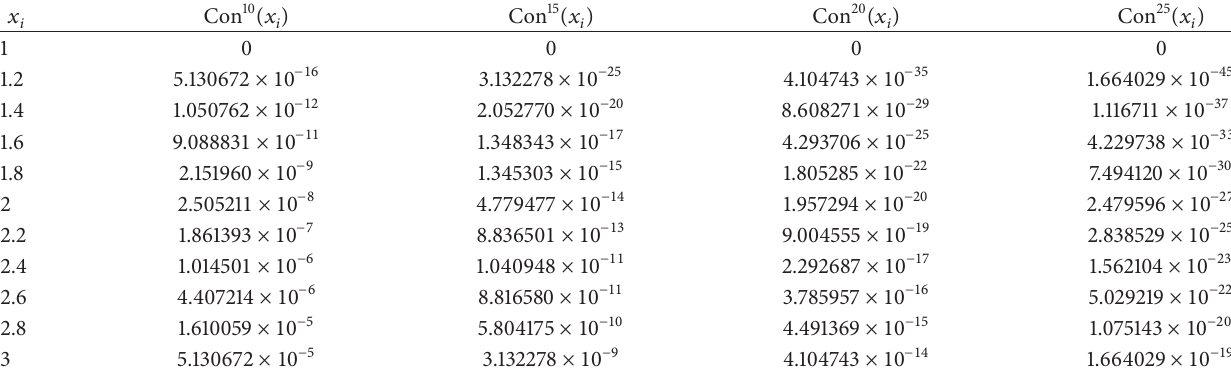
Table 5: The values of the consecutive error function Con 𝑘 (𝑥) to Example 6 when 𝑘 = 10, 15, 20, 25 for different values of 𝑥 in [1,3] . 𝑥